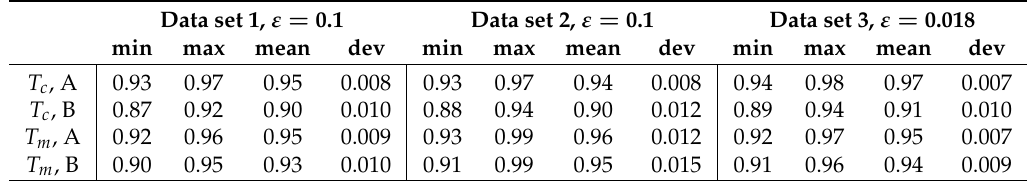
Table 4. Summary of the simulated rejection probabilities at the nominal level 0.05. The rejection probabilities are simulated at the 100 random samples from the HWE distributions e ( p n ) , which are implied by data sets 1, 2 and 3. The sample size equals the size of the corresponding data set. The number of replications is 1000 for each experiment. A stands for the asymptotic test and B stands for the bootstrap